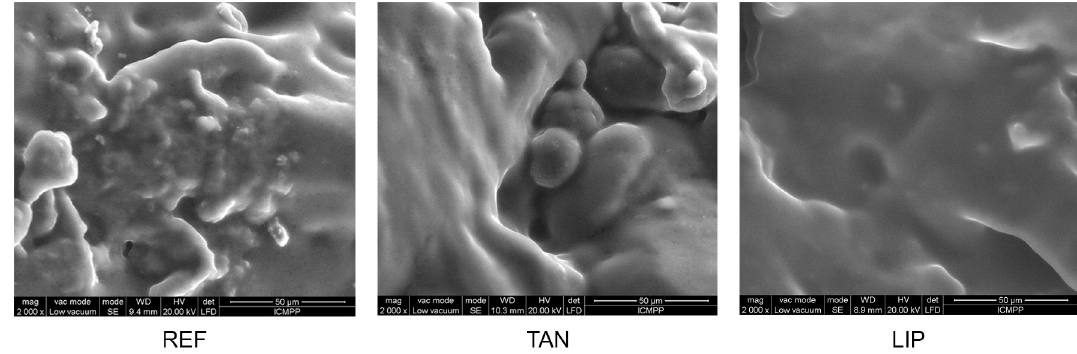
Figure 8. Images of materials. Figure 8. Images of